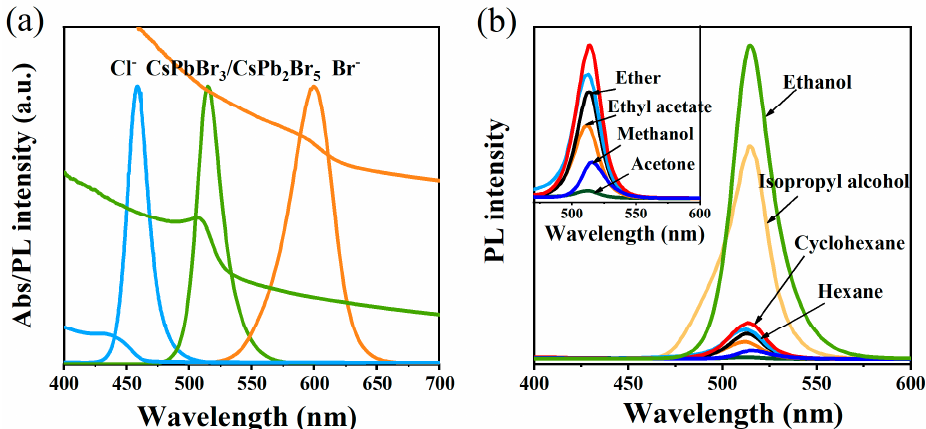
Figure 6. ( a ) UV-vis absorption and PL spectra of NCs synthesized with pure toluene; ( b ) PL spectra of NCs synthesized with different organic solvents: toluene = 0.4.